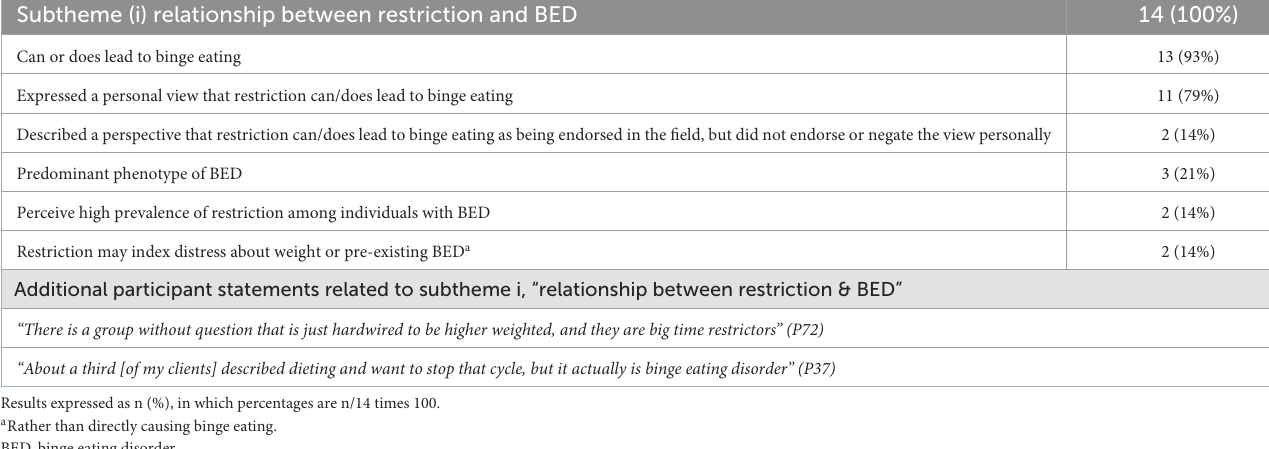
TABLE 6 Participant statements consistent with theme 2, subtheme ii, “forms of restriction” (100%). Subtheme (ii) forms of restriction identified by